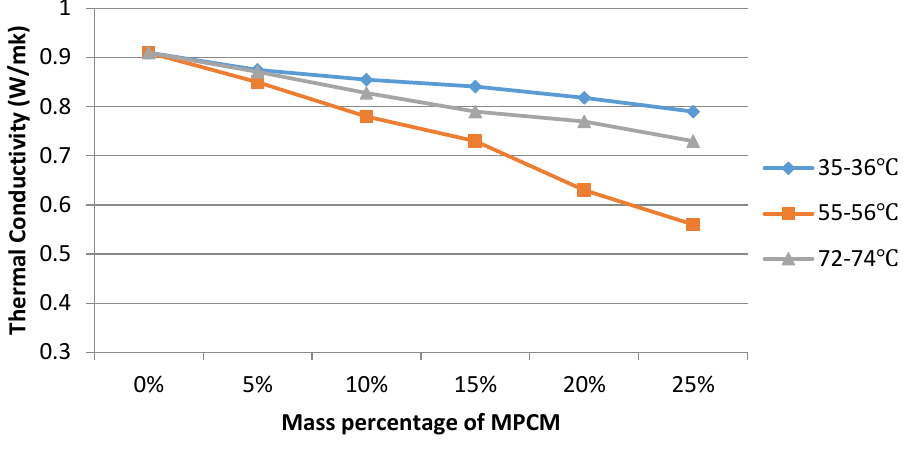
Figure 16. Thermal conductivity of hardened cement paste with MPCM at different average